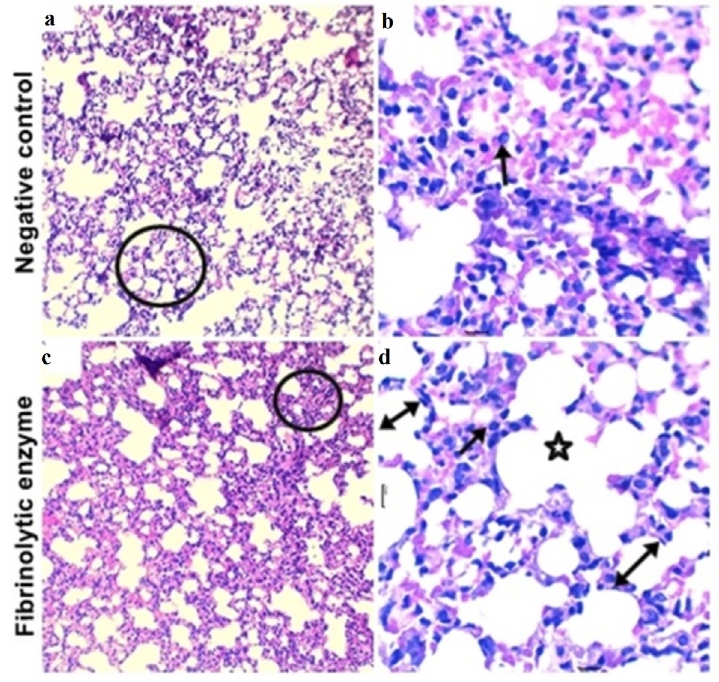
Figure 1. Photomicrographs of lung tissue sections of mice in the different groups studied (H&E).